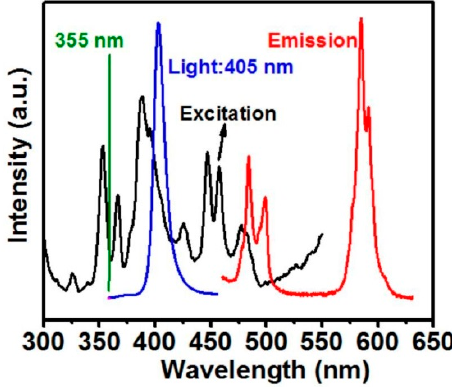
Figure 2. Absorption and emission spectrum of YSZ:Dy.